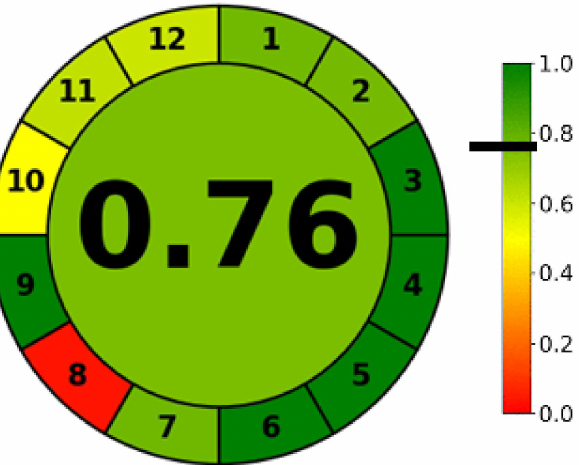
Figure 2. Greenness of the proposed HPLC method using AGREE